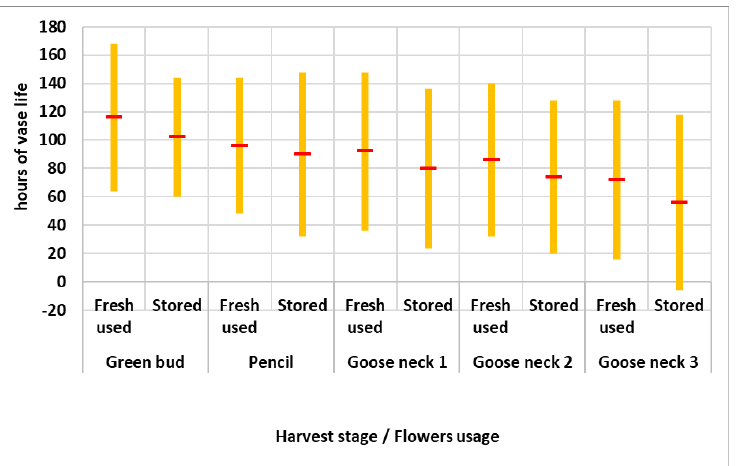
Figure 6. Length of the main characteristic periods of vase life (from left: duration of the period when at least 50% of the flowers were fully open; middle: duration of the period when all flowers were fully open; right: duration of the period from the start of senescence of the first flower to the total wilting of the last flower). Bud stages: green bud (GB); pencil: white bud, upright (PE); goose neck 1: white bud, skew (GN1); goose neck 2: white bud, horizontal (GN2); goose neck 3: big white bud, horizontal, maximum with 1 opening petal (GN3).